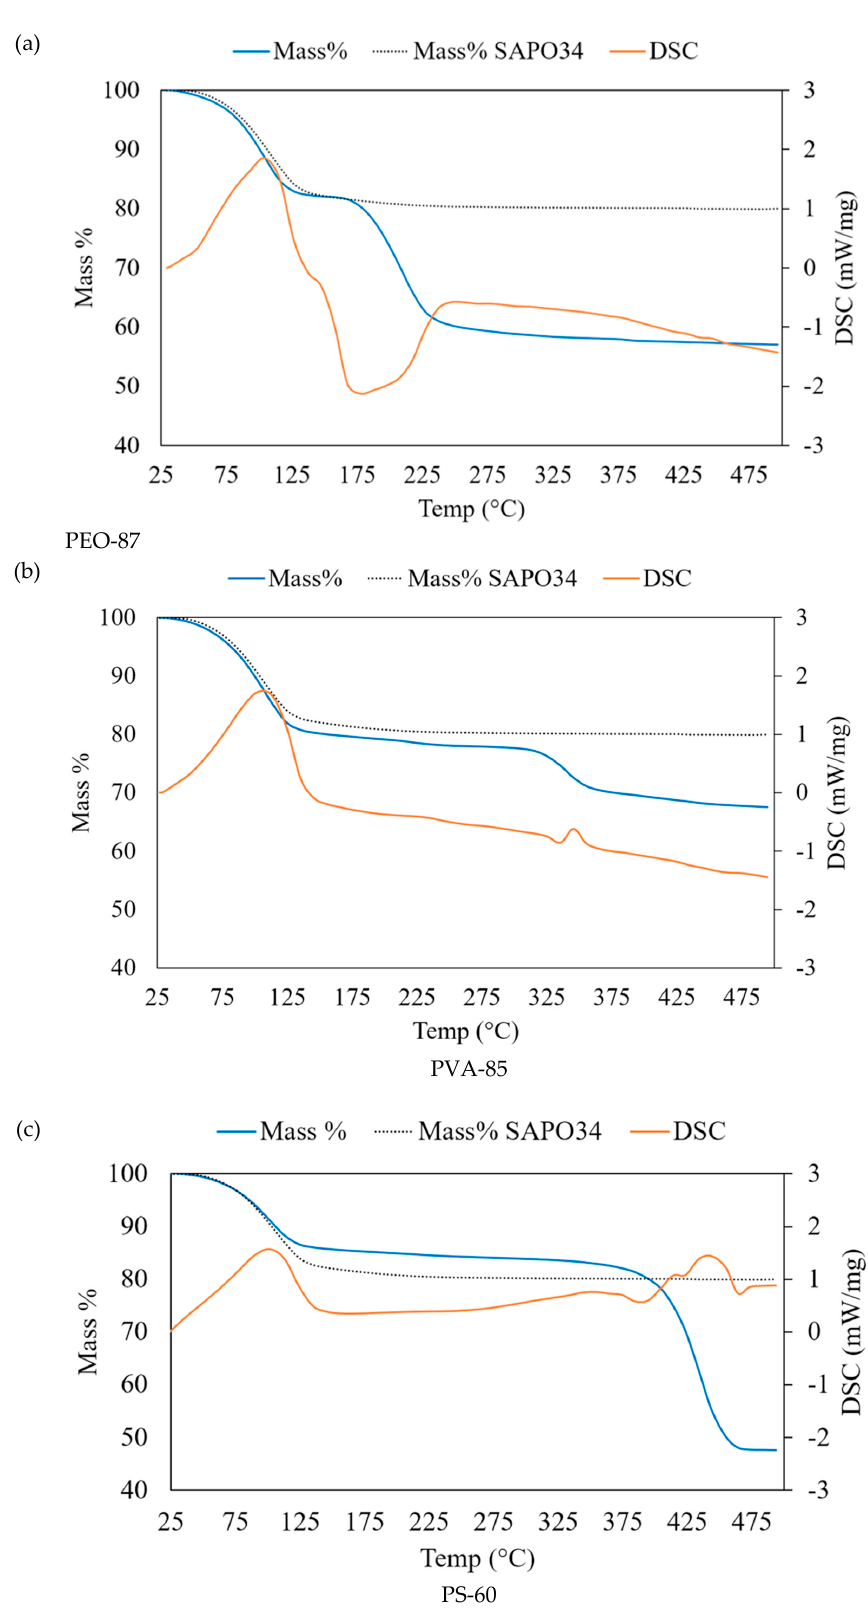
Figure 10. TGA-DSC curves of ( a ) PEO-87, ( b ) PVA-85 and ( c ) PS-60. TGA of SAPO-34 is shown for